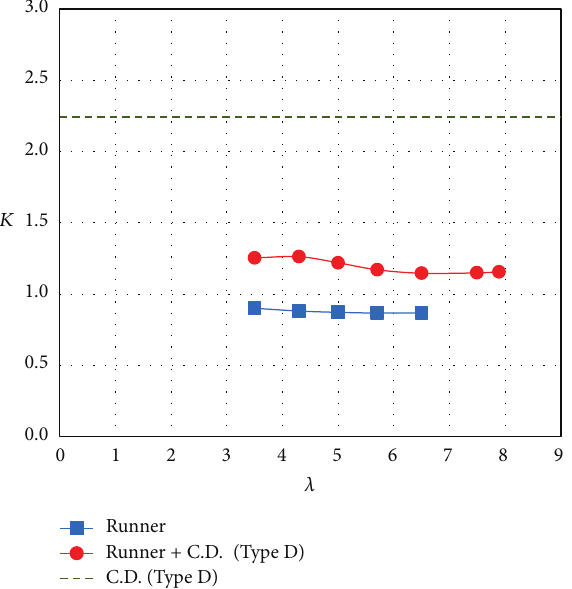
Figure 14: Correlation between the tip speed ratio and the inlet velocity